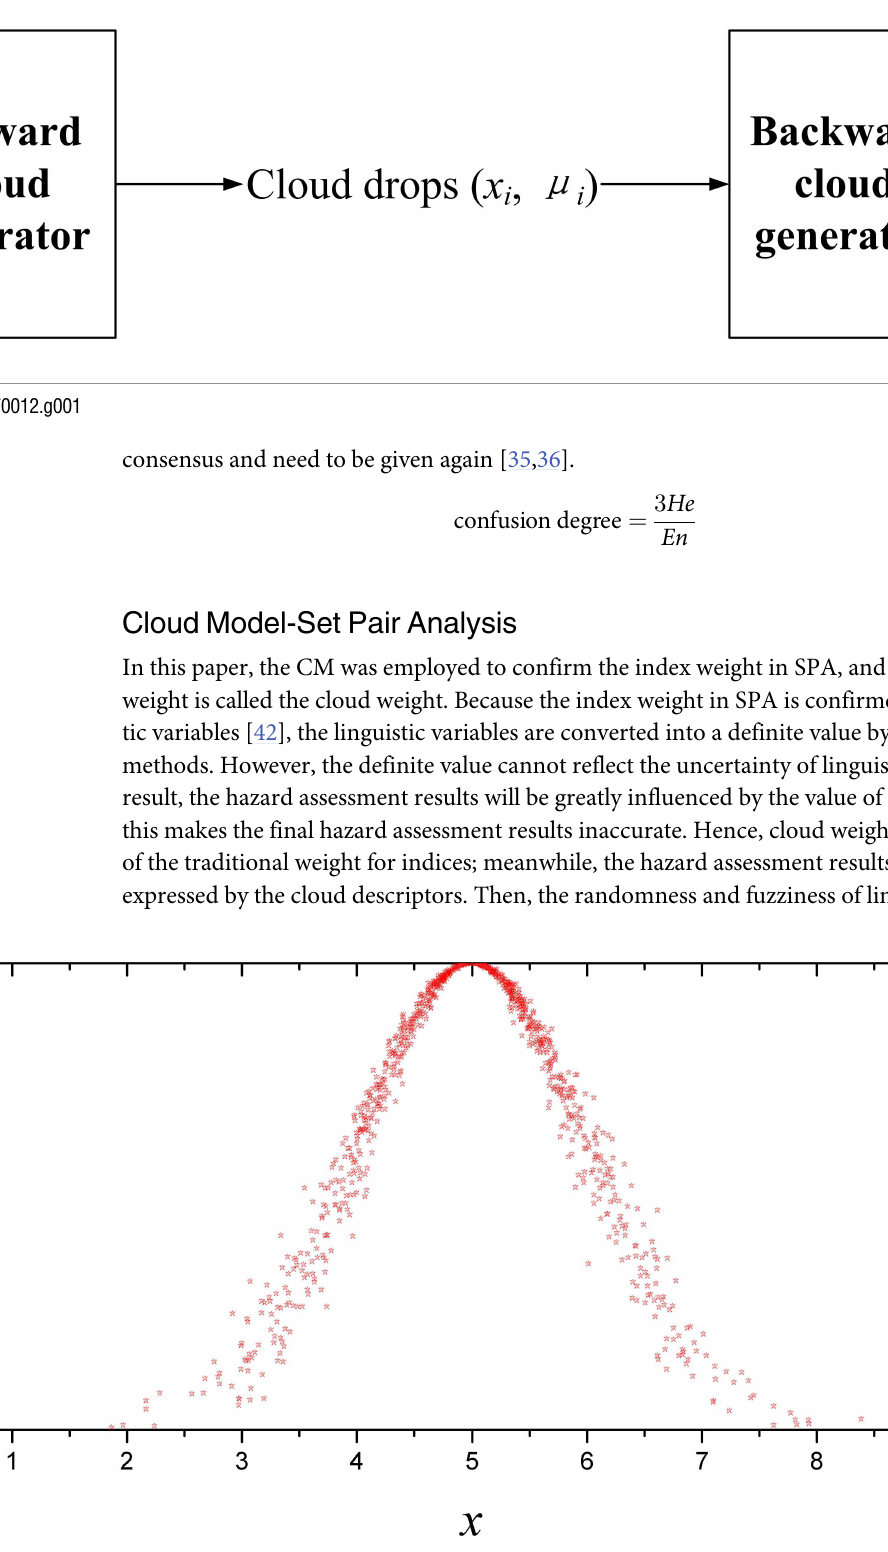
Fig 2. An example of a normal